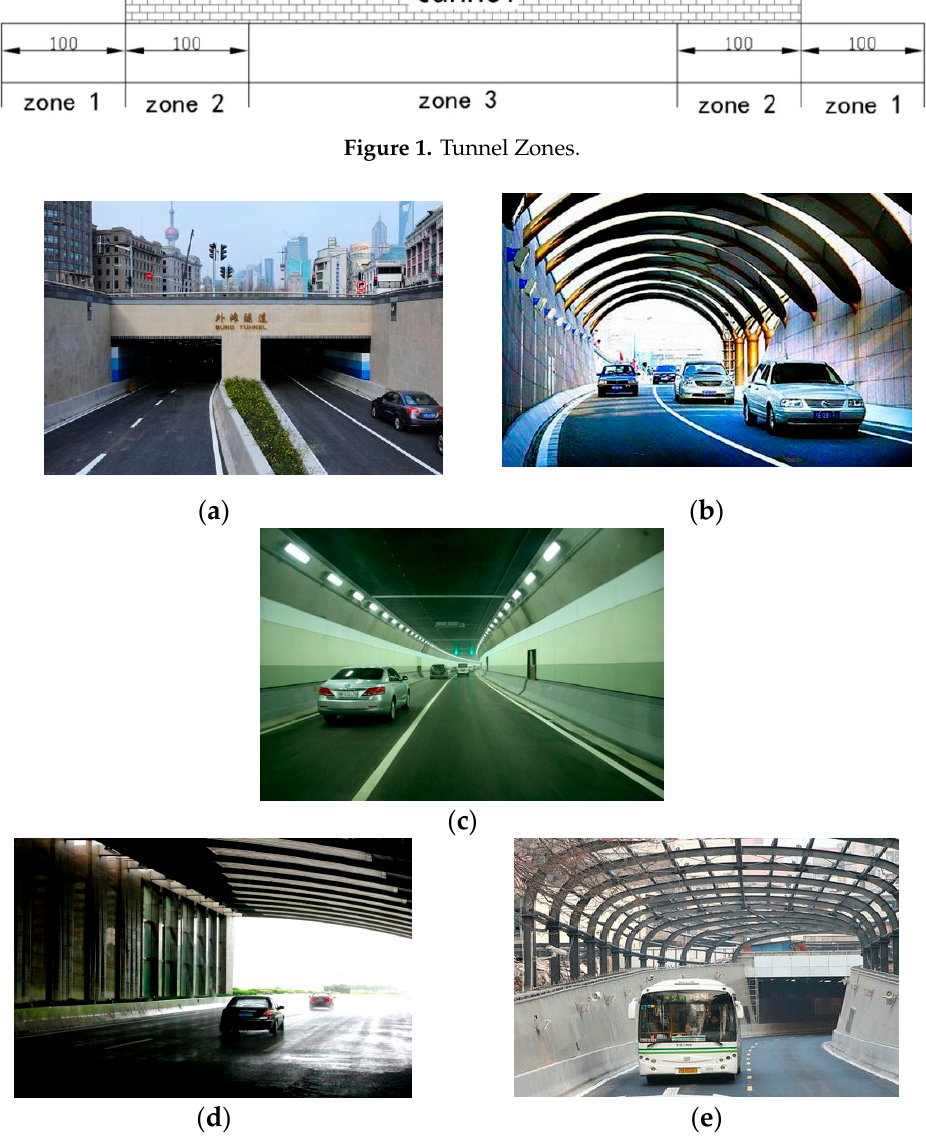
Figure 2. Different Tunnel Zones: ( a , e ) Zone 1; ( b , d ) Zone 2; ( c ) Zone 3. (Data source: Baidu Picture). Table 2. Descriptive Statistics of Variables.